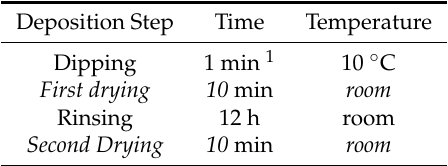
Table 3. Fabrication step details of the deposition procedure with optimized drying steps.